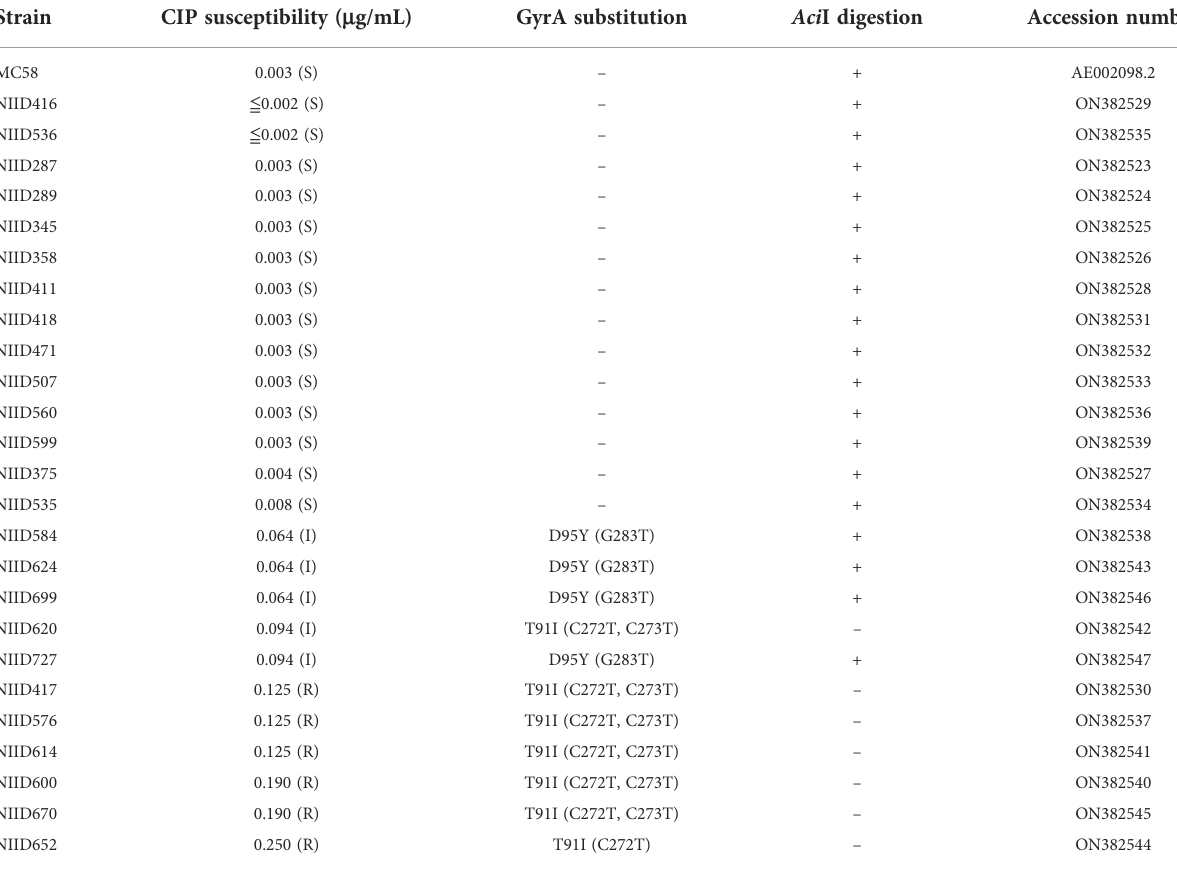
TABLE 1 Distribution of CIP susceptibility, GyrA substitution, and Aci I digestion pattern in meningococcal strains. Strain CIP susceptibility ( m g/mL) GyrA substitution